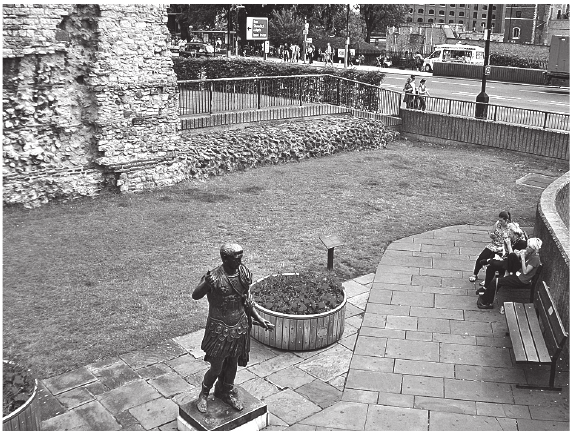
londono Taueryje, 2011 m. Fig. 4. Exposed fragment of londinium wall in the Tower of london,